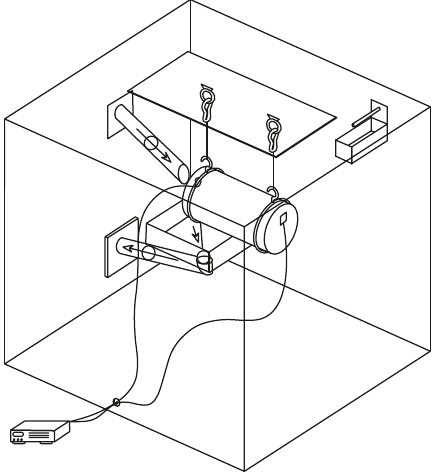
Figure 1: Flow chart of the EKF algorithm.